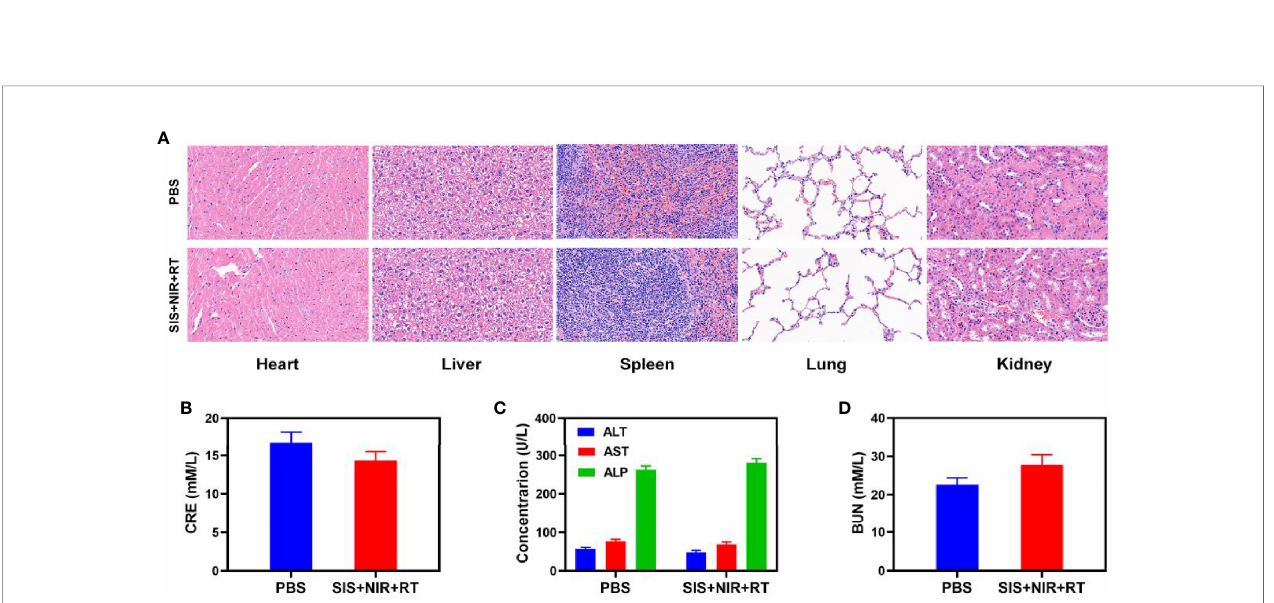
FIGURE 4 | Result of in vivo safety experiments. (A) Histopathological analysis results (H&E stained images) of the major organs, heart, lung, liver, kidneys, and spleen, of mice that were exposed to different treatments 16 days post-injection. Blood biochemistry data including kidney function markers: (B) liver function markers: CRE, (C) ALT, ALP, and AST and (D) BUN after various